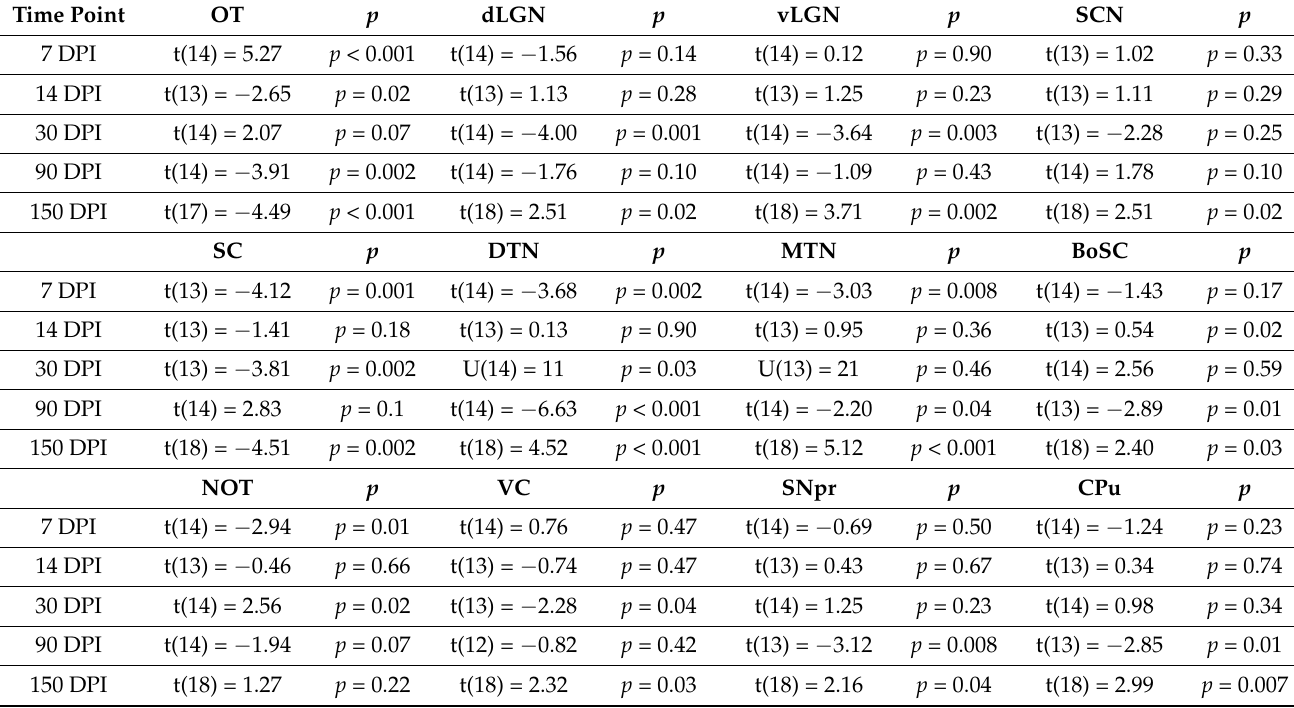
Table 3. Statistics for